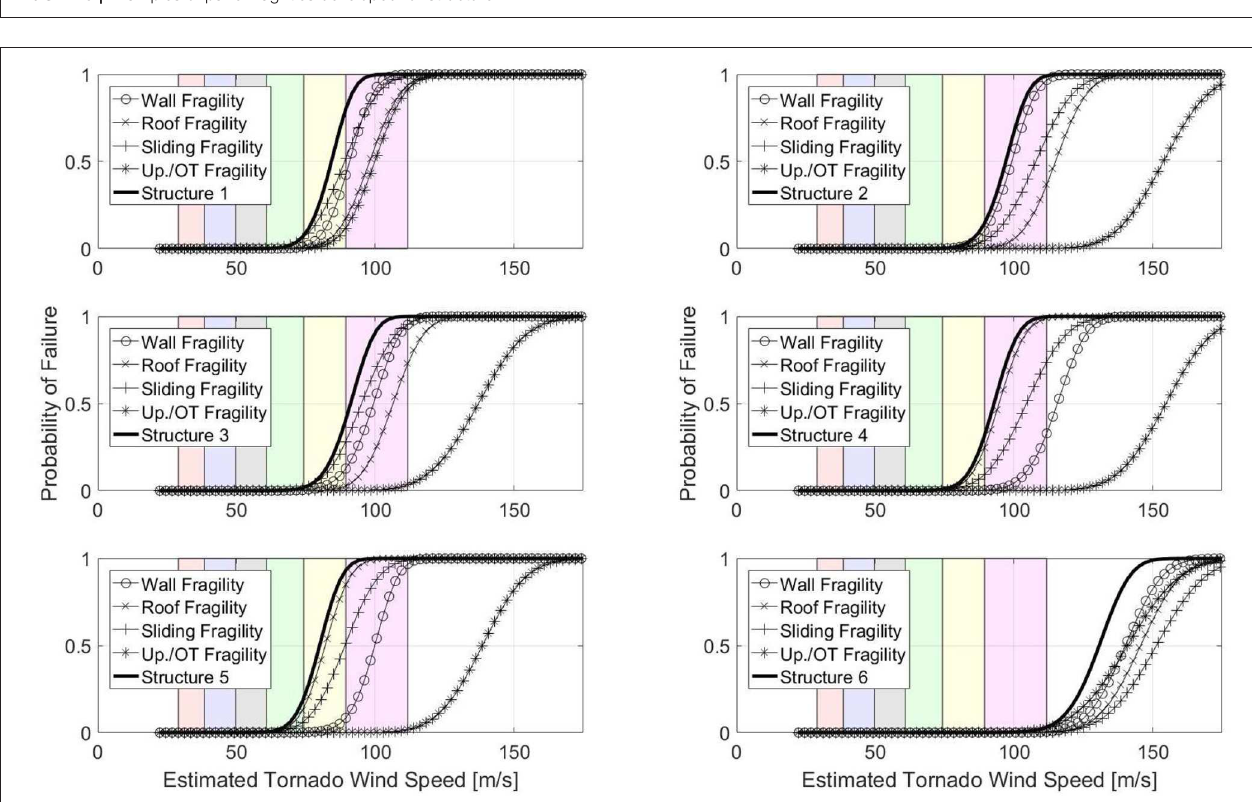
FIGURE 7 | Wall, roof, and system fragilities for each structure type.